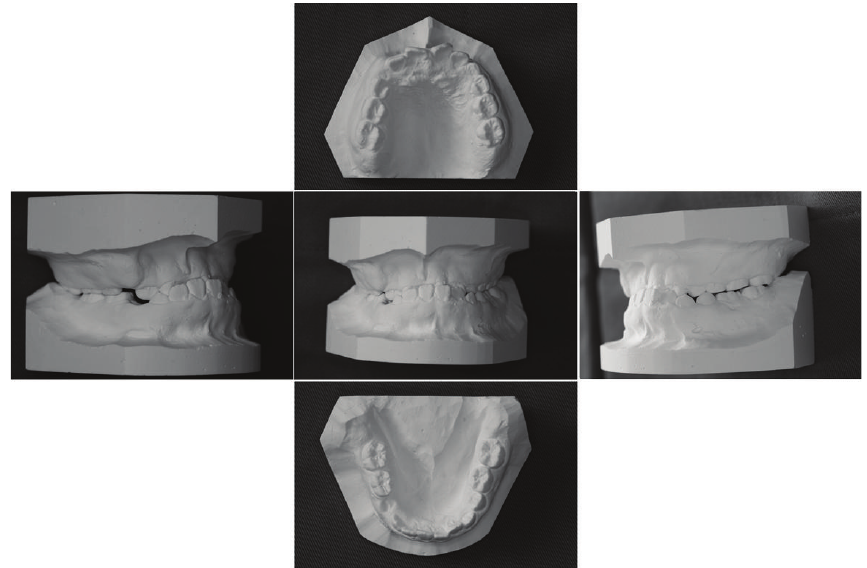
Figure 3: Study cast taken at the age of 12 years and 6 months.